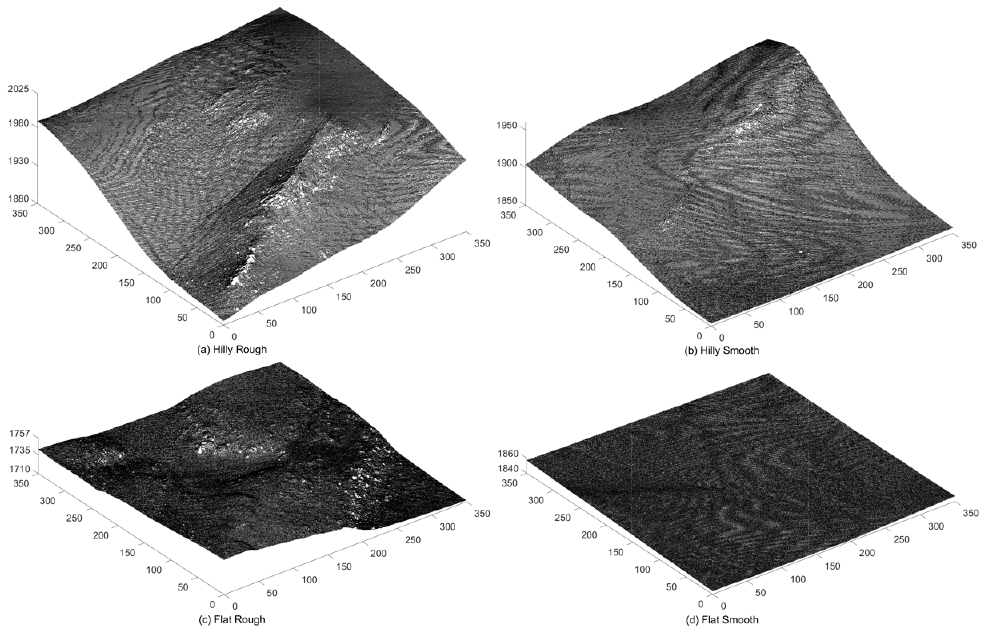
Figure 2. The light detection and ranging (LiDAR) point cloud datasets investigated.